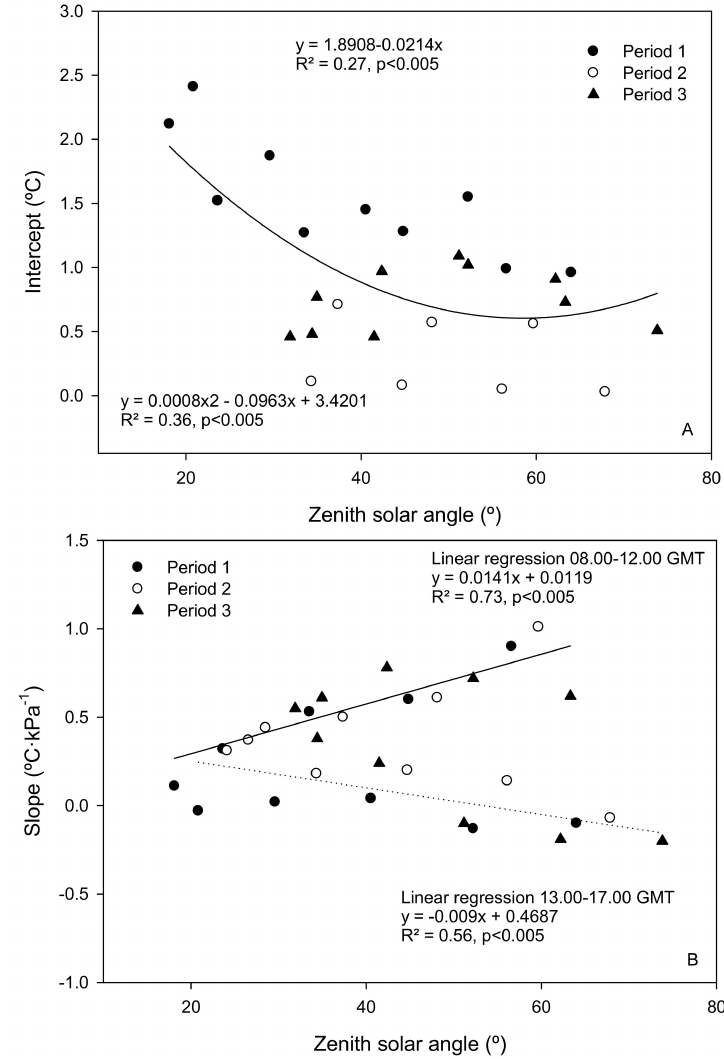
Figure 7. Relationships of zenith solar angle ( θ Z) with ( A ) NWSB-intercepts and ( B ) NWSB-slopes for the three different periods: 1 (P1, DOY 193-212), 2 (P2, DOY 213-239), and 3 (P3, DOY